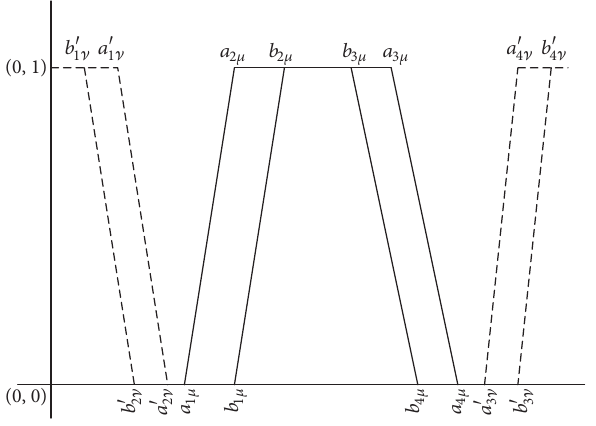
score function that can cover some subclass of TrIFNs which cannot be covered by 𝐽 1